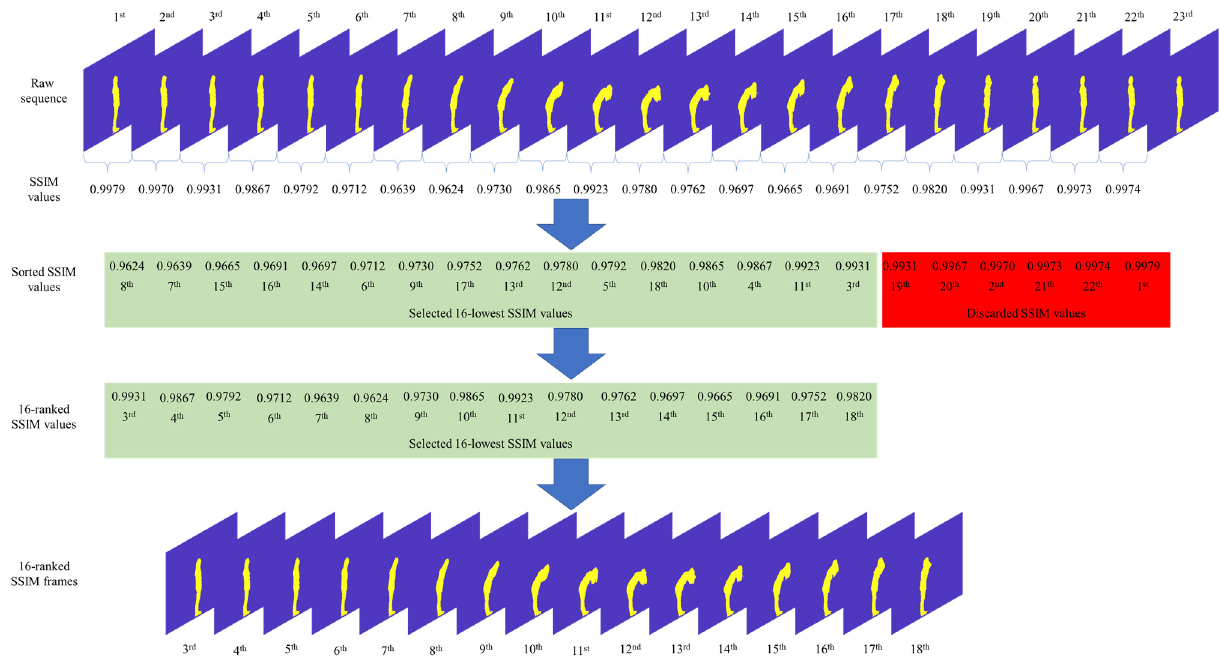
Figure 3. 16-ranked key-frames selection using SSIM ranking method.